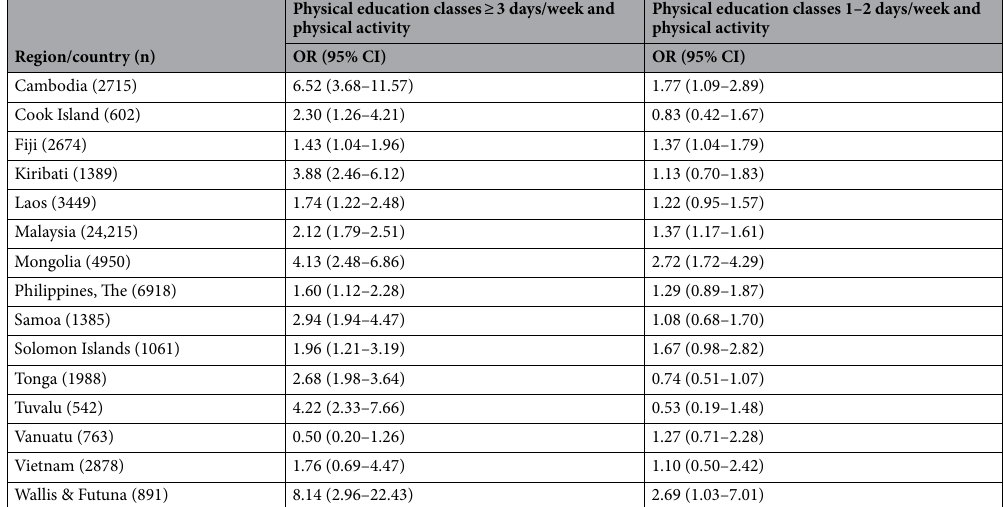
Table 1. Country-level adjusted a and region-level pooled estimates of association between frequency of physical education classes and sufficient physical activity among adolescents aged 11–17 years, Global School- based Student Health Surveys, 2007–2016. OR odds ratio, CI confidence intervals, UAE United Arab Emirates. a Reference being attending no physical education class. Adjusted for age, sex, weight status (i.e., BMI), food insecurity, and sitting